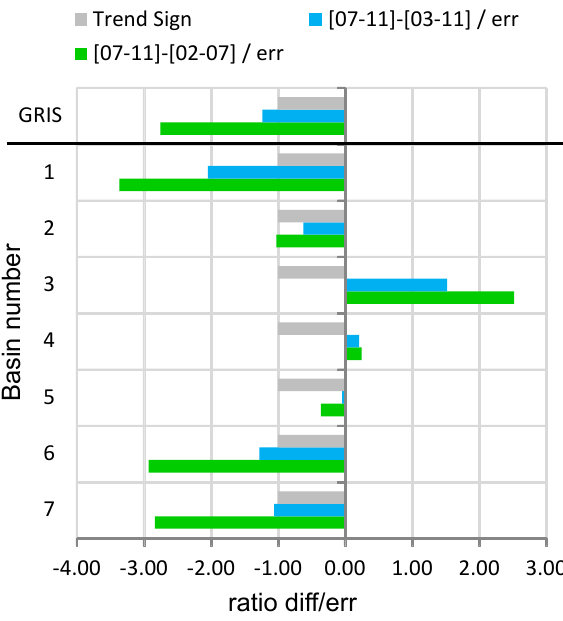
Fig. 11. Acceleration summary for Greenland. The same as in Fig.